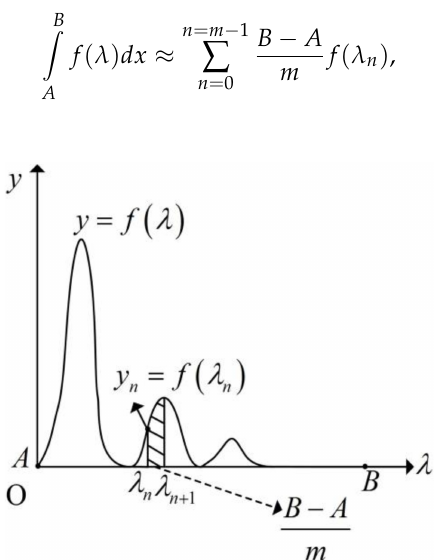
Figure 6. Numerical integration method for the analytical